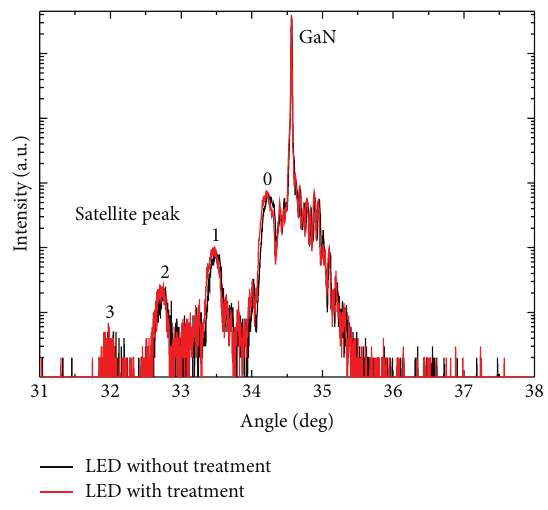
Figure 2: XRD spectra for the LEDs prepared with and without TMIn